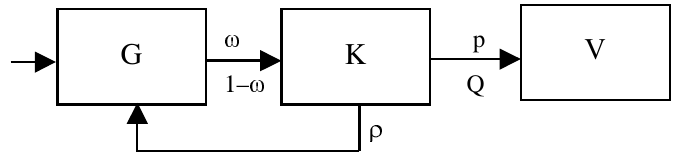
Fig 2. Structural scheme of one-phase control production